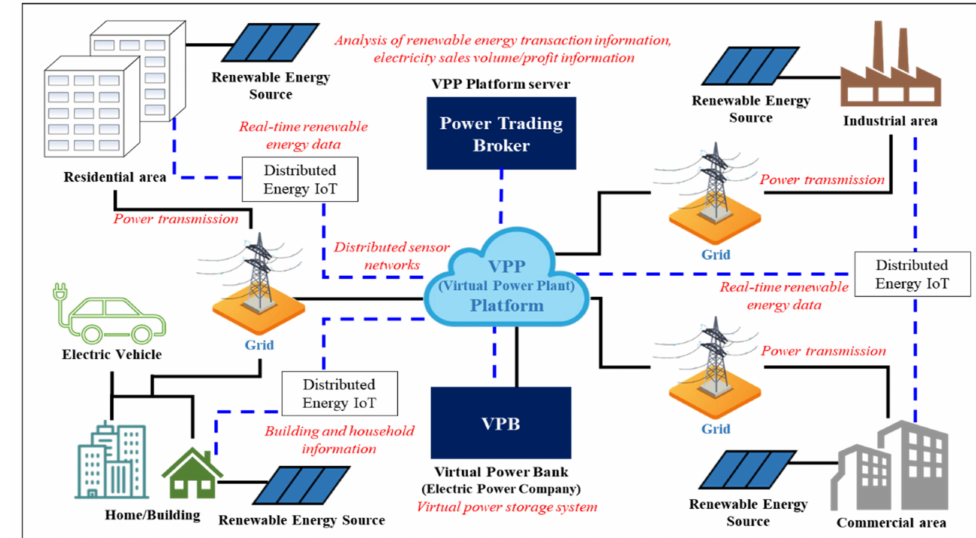
Figure 1. Schematic diagram of the total energy trading